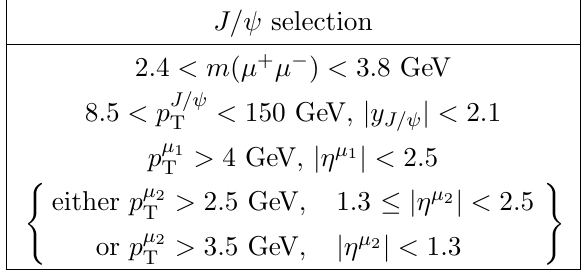
Table 2. De(cid:12)nition of the (cid:12)ducial region for the J= cross section measurement, where (cid:22) 1 is the highest- p T muon from the J= decay, and (cid:22) 2 is the second-highest- p T muon from the J=